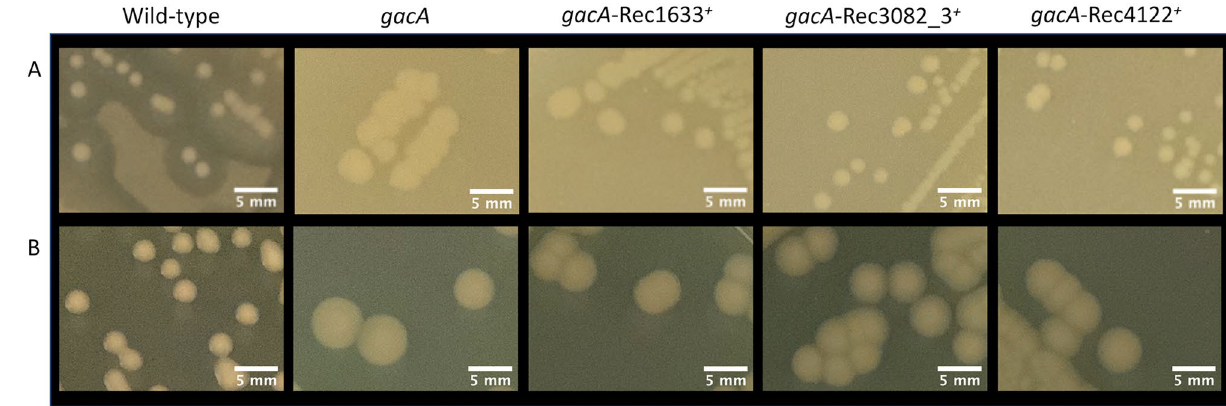
Figure 3. GacA is required for GacS chimeras to restore wild-type phenotypes. Lack of restoration of the wild- type strain phenotypes by expression of GacS chimeras in the gacA mutant. Protease activity (lysis zone) on skim milk medium ( A ) and colony appearance on PAF medium ( B ).